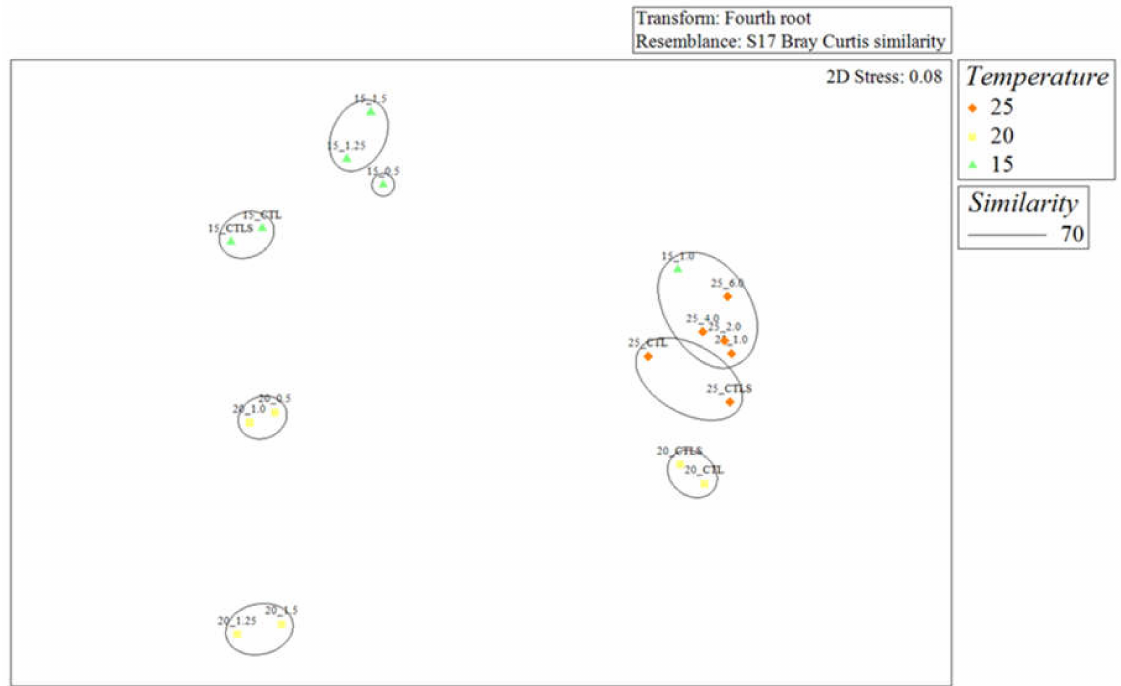
Figure 4. Two-dimensional non-metric MDS ordination plot of the FA contents of T. weissflogii exposed to oxyfluorfen at the three temperatures (15 ◦ C, 20 ◦ C, and 25 ◦